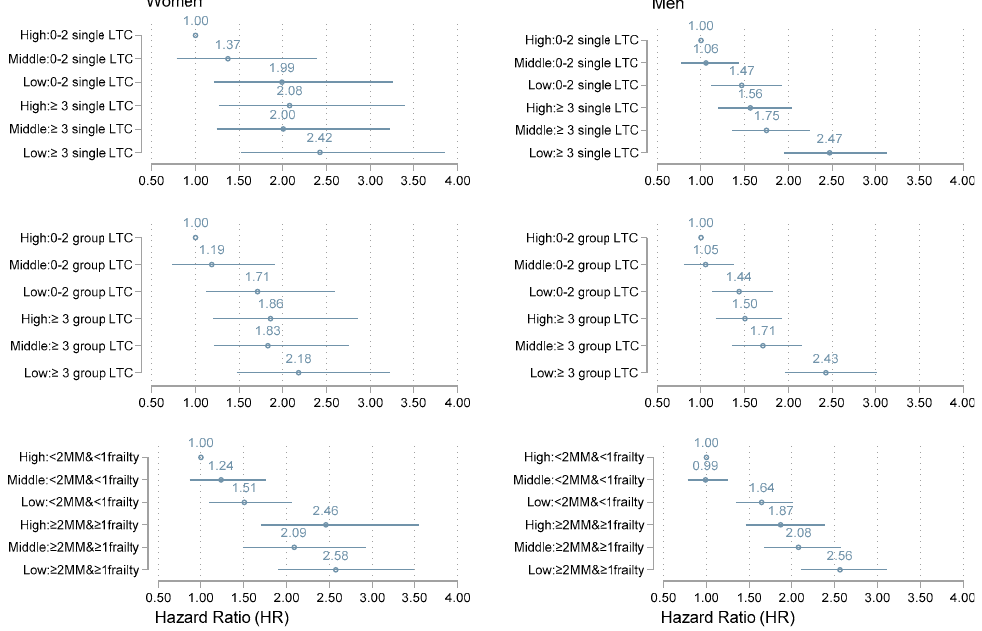
Figure 3. Hazard Ratios and 95% CIs for all-cause mortality between occupational groups with and without multimorbidity, separate for men and women. Abbreviations: LTC = long-term condition; MM, multimorbidity; 2MM & 1frailty = two individual long-term conditions plus one dimension of frailty (poor self-rated health, mental illness, physical impairment, or social impairment). Top panels, multimorbidity with a threshold of at least three individual long-term conditions; middle panels, multimorbidity as a threshold with at least three organ-grouped long-term conditions; bottom panel, multimorbidity with more than two individual long-term conditions and frailty.